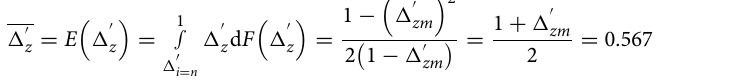
concealed, as shown in Fig. 1, where particle 4 is completely concealed by particle 3. When � ′ z < � ′ zv , the prob- ability distribution function of vertical relative exposure is 0, and the slurry particles are at the dispersed state. As demonstrated by particles 1 and 3, the relative exposure between them is 0. When (cid:31) ′ z (cid:31) ′ zm ( (cid:31) ′ zm particles are closely arranged and at the lower limit state, as shown in Fig. 1. The expected vertical relative exposure is: